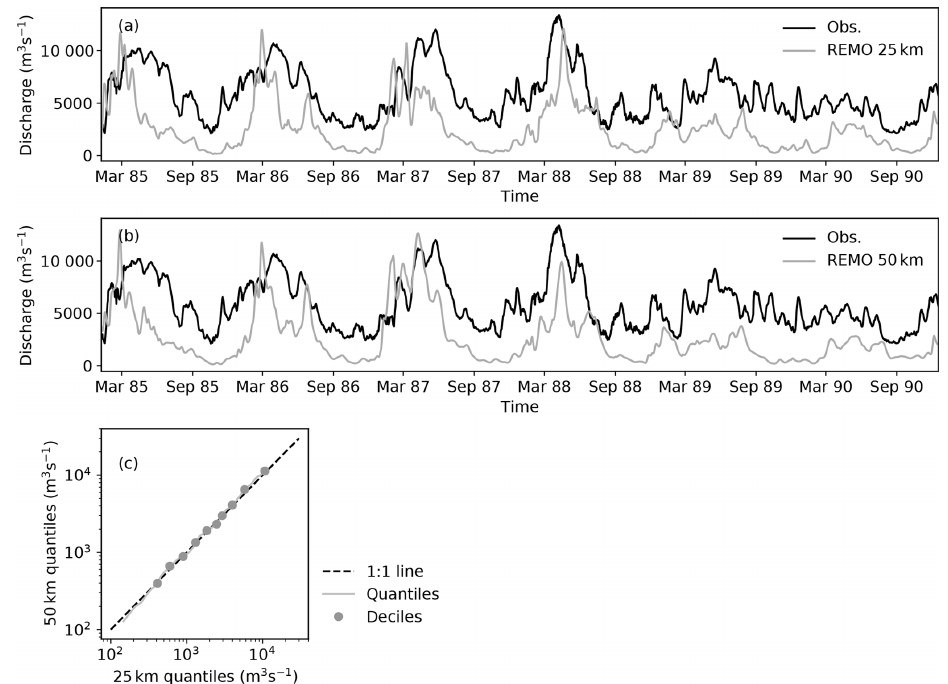
Figure D1. Same as Fig. 7, but using REMO simulations from the ENSEMBLES